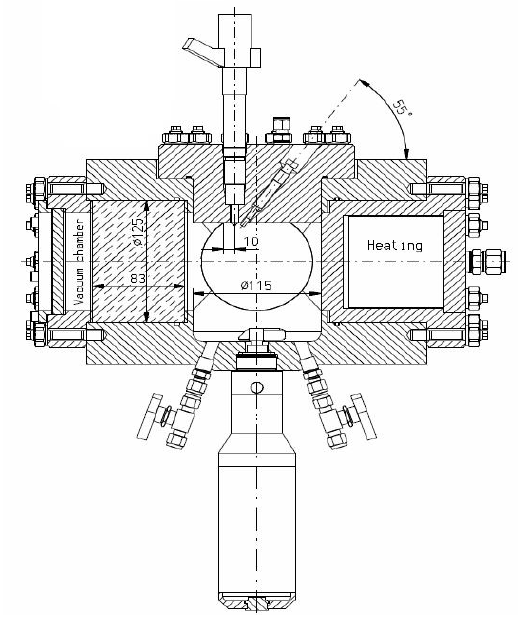
Figure 1. Schematic of constant ‐ volume vessel.